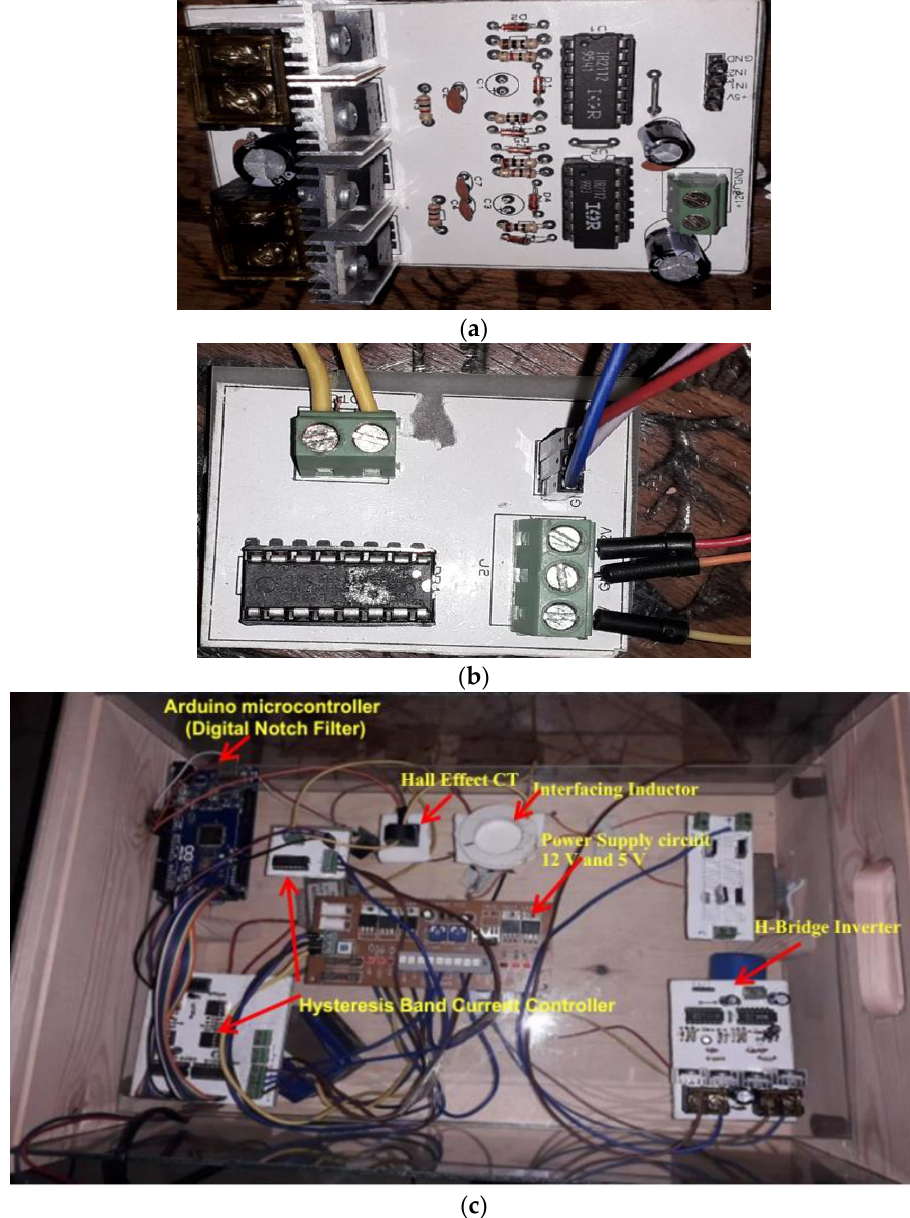
Figure 11. Hardware implementation of single-phase SAPF using DSP board ( a ) H-Bridge Inverter for 220 V load; ( b ) H-Bridge Inverter for 12 V load; ( c ) overall design of single-phase SAPF.